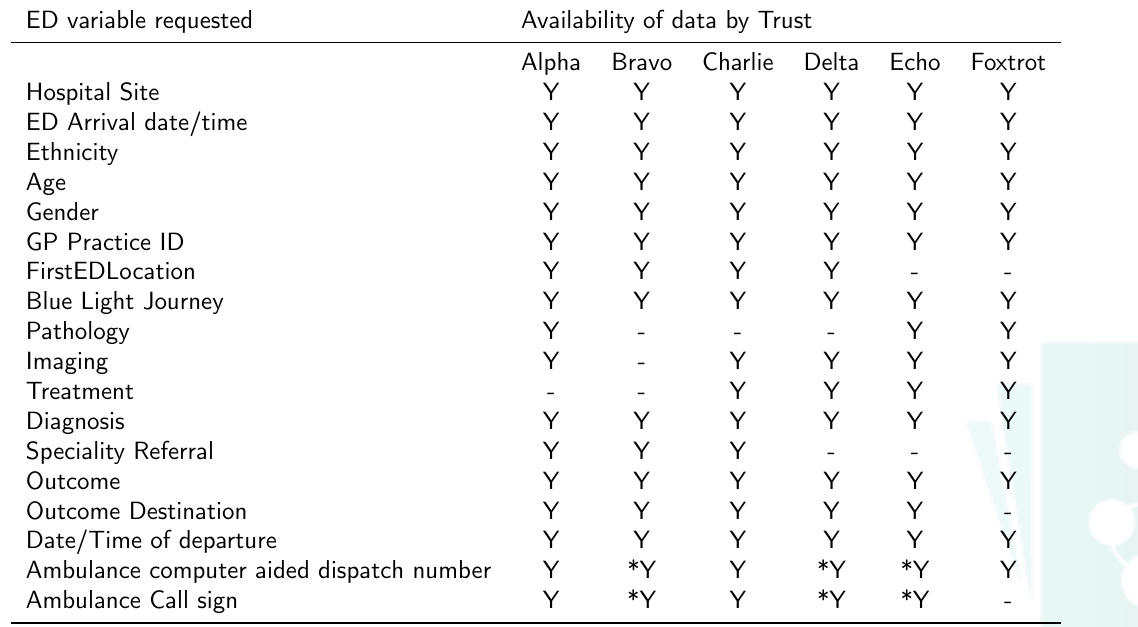
Table 3: Availability of requested data from Emergency Departments